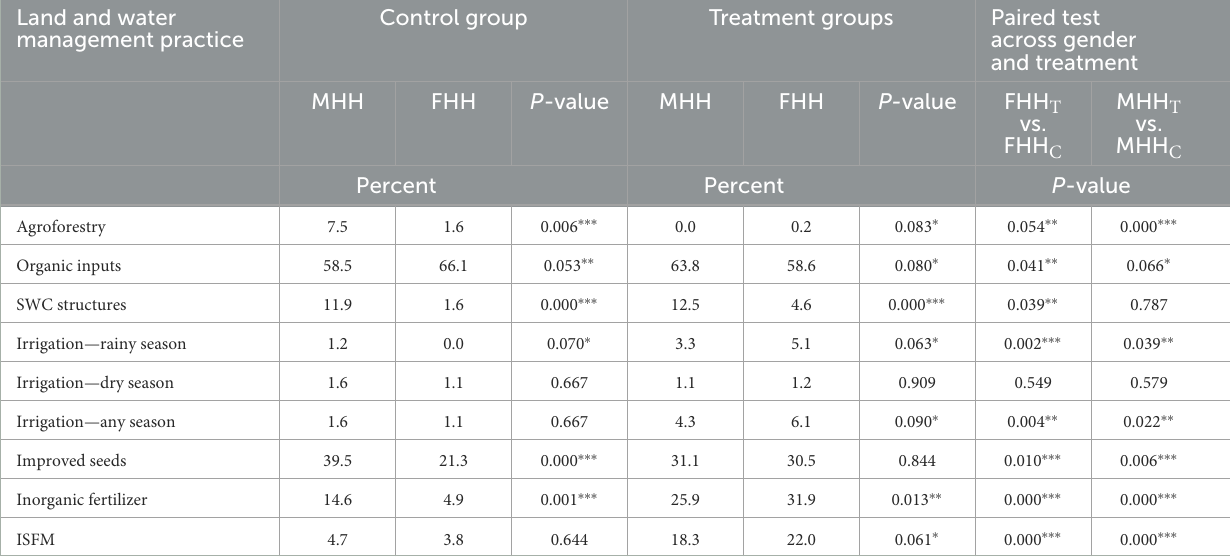
TABLE 7 Adoption rate of land and water management practices that enhance resilience of shocks. Land and water Control group Treatment management practice